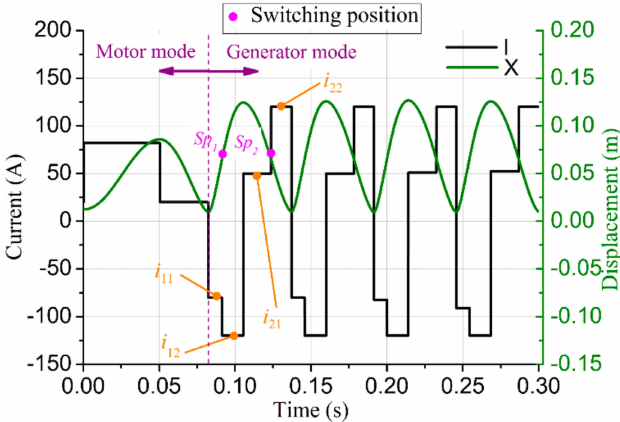
Figure 9. The schematic diagram of the Ladder-like control